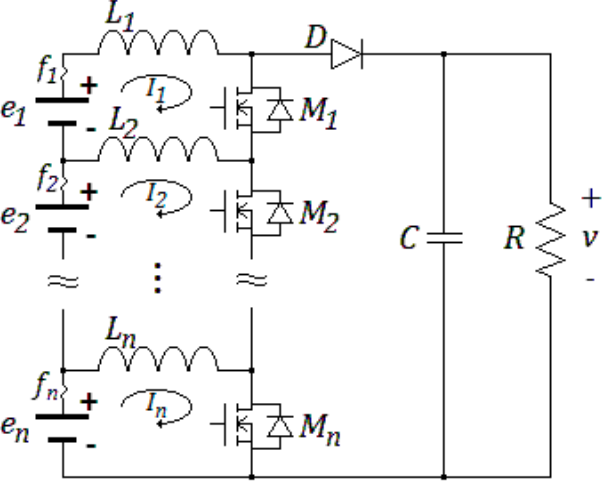
Figure 1. Proposed DC-DC, vehicle-to-aid (V2A) converter, basic schematic.